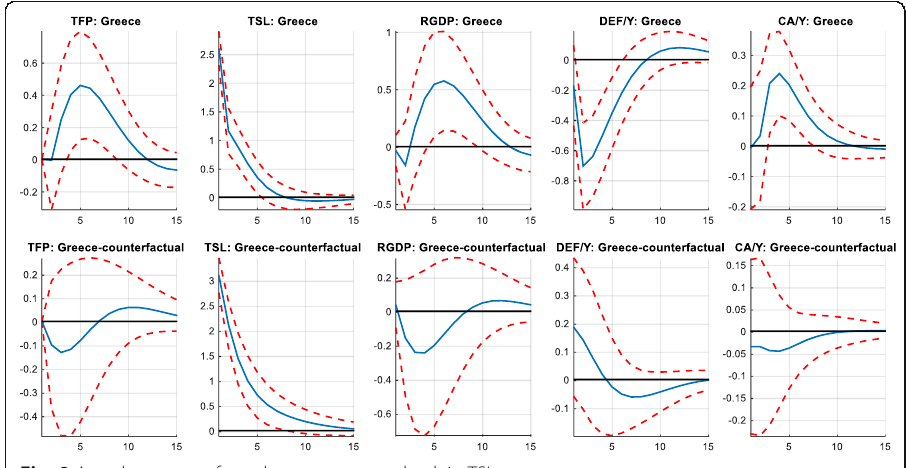
Fig. 8 Actual vs counterfactual responses to a shock in